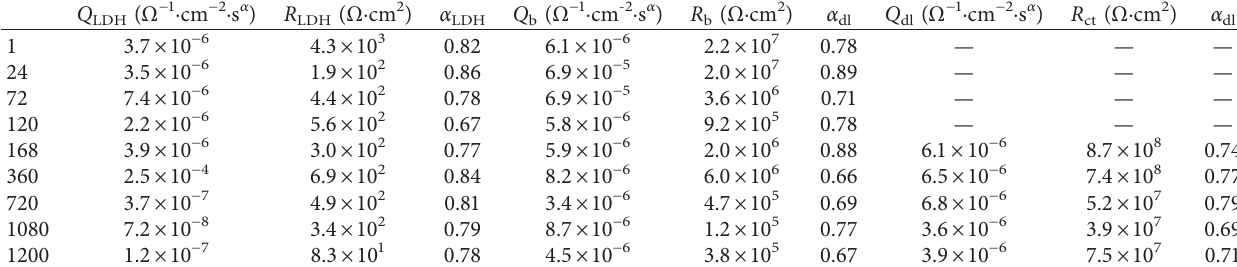
Table 2: Results of the EIS fittings of CeLDH.